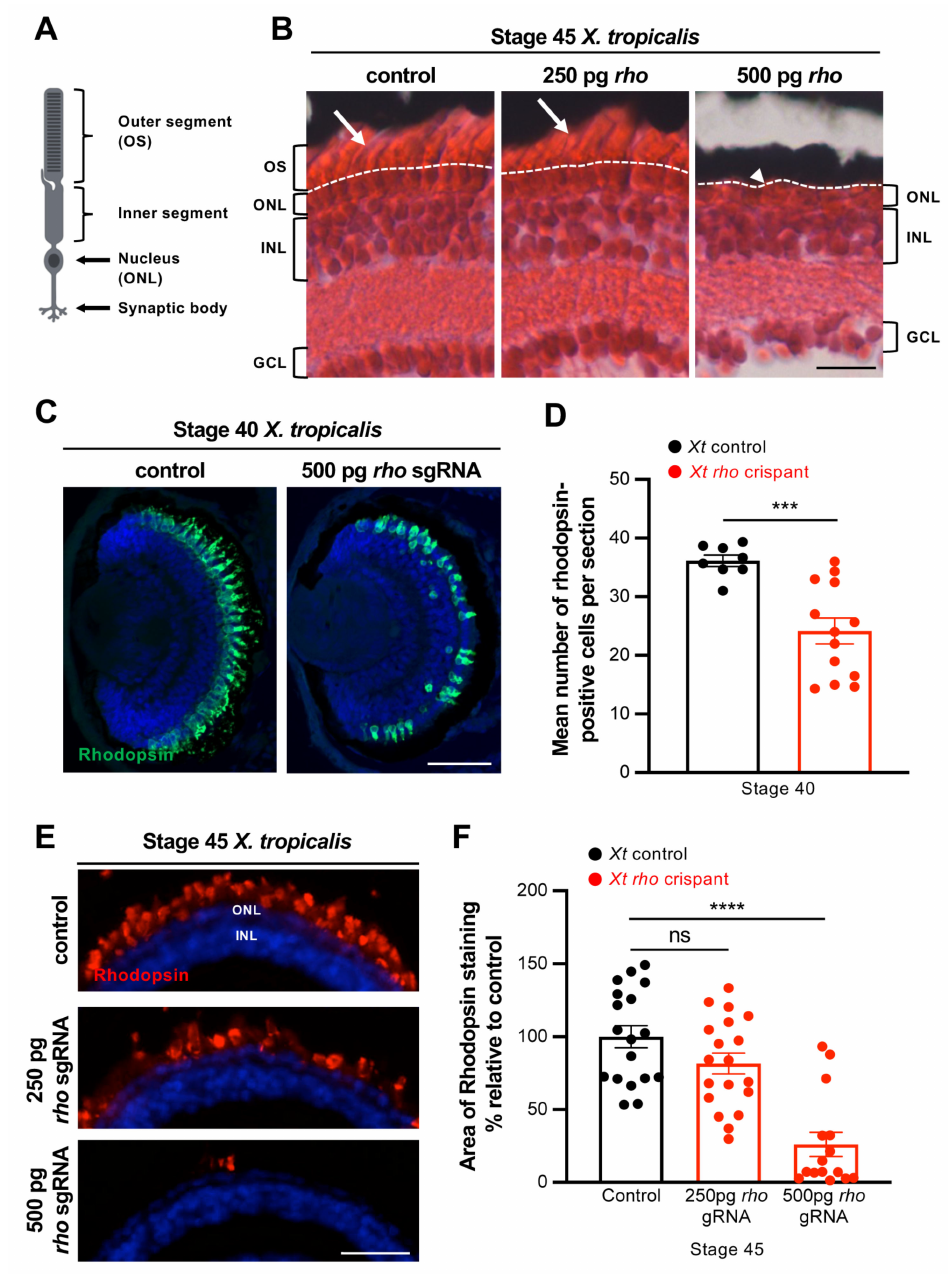
Figure 2. Rod degeneration in X. tropicalis rho crispants. ( A ) Schematic representation of a rod photoreceptor. ( B ) Hematoxylin and Eosin staining on retinal sections from stage 45 control and rho crispant X. tropicalis tadpoles. The dotted line delineates the border between the outer nuclear layer and photoreceptor outer segments (arrows). The arrowhead indicates the absence of outer segments. ( C – F ) Immunofluorescence analysis of Rhodopsin expression on retinal sections from stage 40 ( C , D ) and stage 45 ( E , F ) control and crispant X. tropicalis tadpoles. Rhodopsin labels the rod outer segments. The number of Rhodopsin-positive cells and the area of Rhodopsin staining are quantified in ( D , F ), respectively. In ( C , E ), cell nuclei are counterstained with Hoechst (blue). In graphs, data are represented as mean ± SEM and each point represents one retina. *** p < 0.001; **** p < 0.0001; ns: non-significant (Mann–Whitney tests). GCL: ganglion cell layer, INL: inner nuclear layer, ONL: outer nuclear layer, OS: outer segment. Scale bars: 25 µ m in ( B , E ) and 50 µ m in ( C